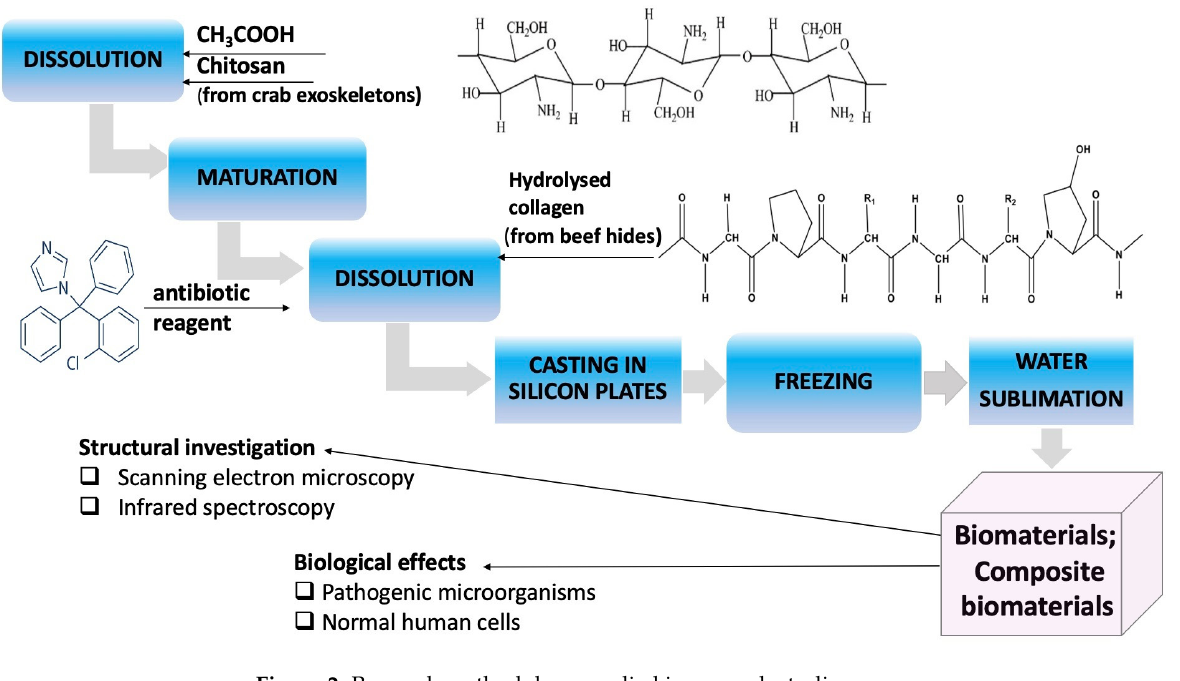
Figure 2. Research methodology applied in research studies.